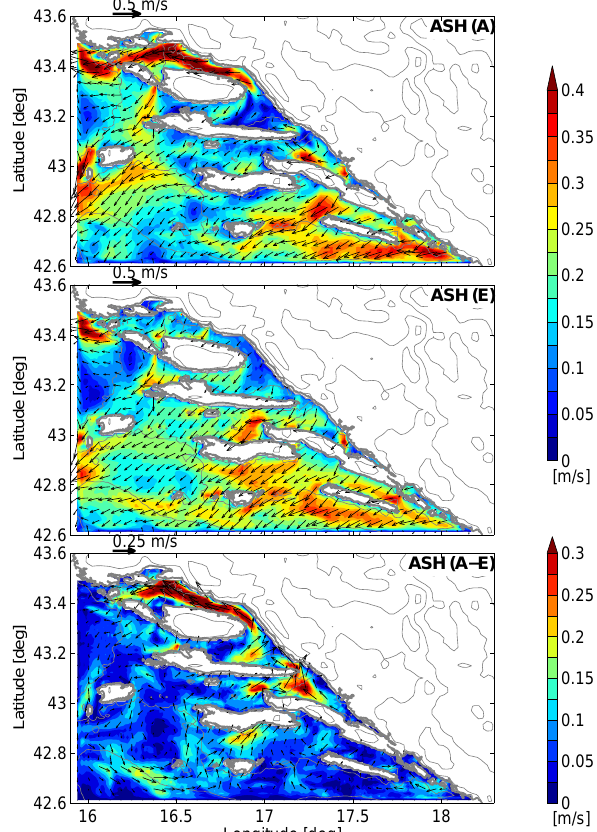
Fig. 3. The ASHELF-2 modeled mean surface currents for the B2 Bora period (Table 1) obtained by ALADIN and ECMWF forc- ing (top and center panels, respectively) and the differences be- tween these two. Additionally, the magnitudes of vector differences | ALADIN-ECMWF | are shown in colors.